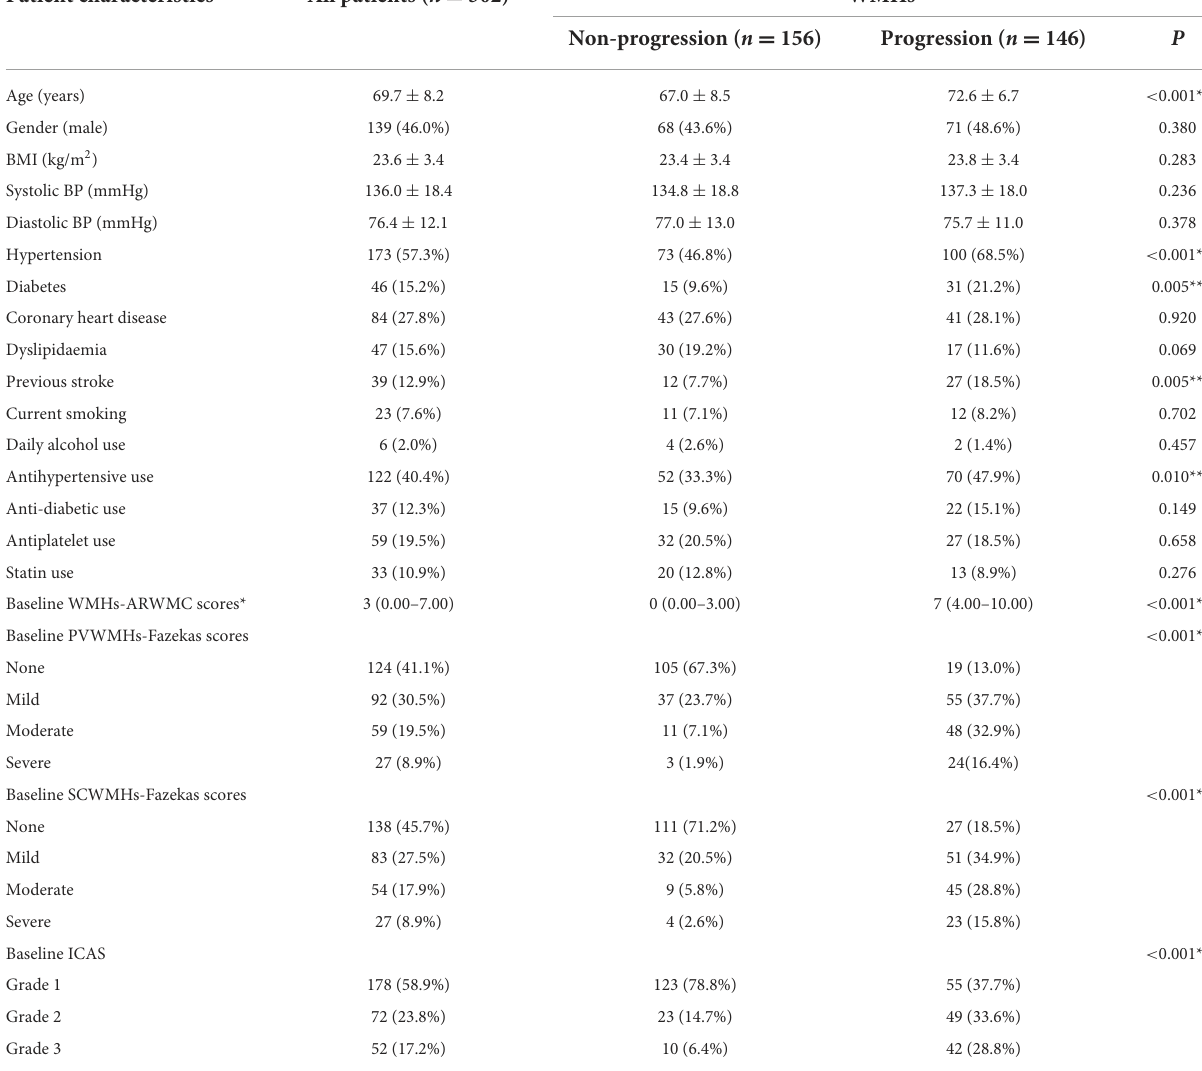
TABLE 1 Characteristics of patients with and without WMHs